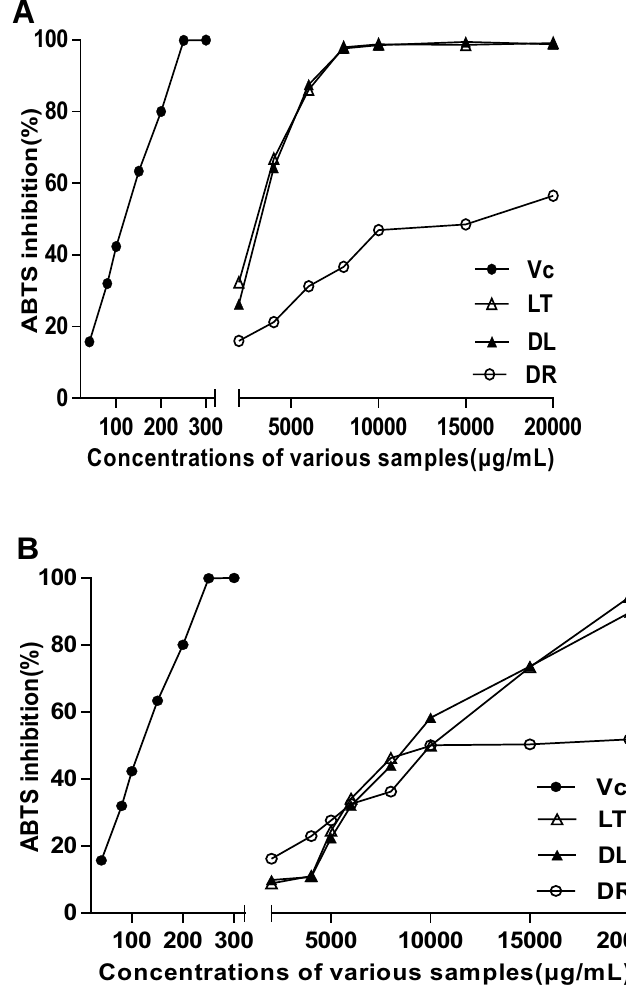
Figure 2. Inhibition of 2,2-azino-bis-(3-ethyl-benzothiazoline-6-sulfonic acid) (ABTS) radical for ethanol water-soluble extracts samples ( A ) and ethanol-soluble extracts samples ( B ) from DL (filled triangle), processed LT (open triangle) and medicinal DR (open circle) of A. membranaceus , compared with Vc (closed circle); DL, dry leaves; LT, leaf tea ; DR, dry roots; Vc, vitamin